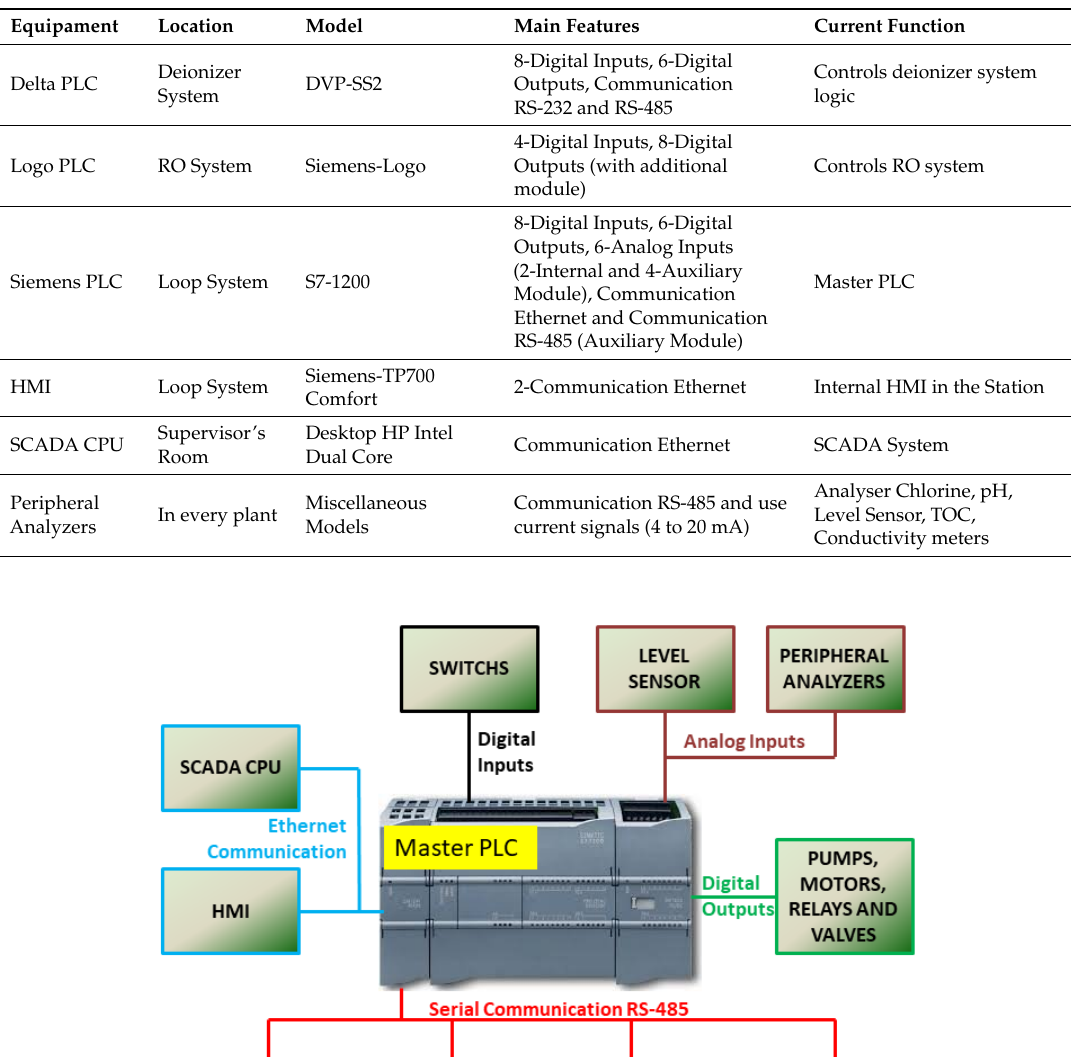
Table 2. Leading Equipment.